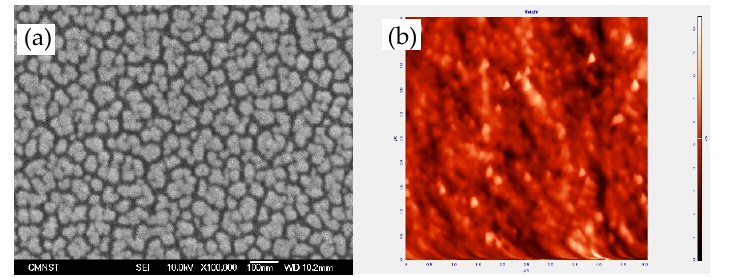
Figure 3. The top-view images of ( a ) FESEM and ( b ) AFM of the In 0.9 Ga 0.1 O sensing membrane.